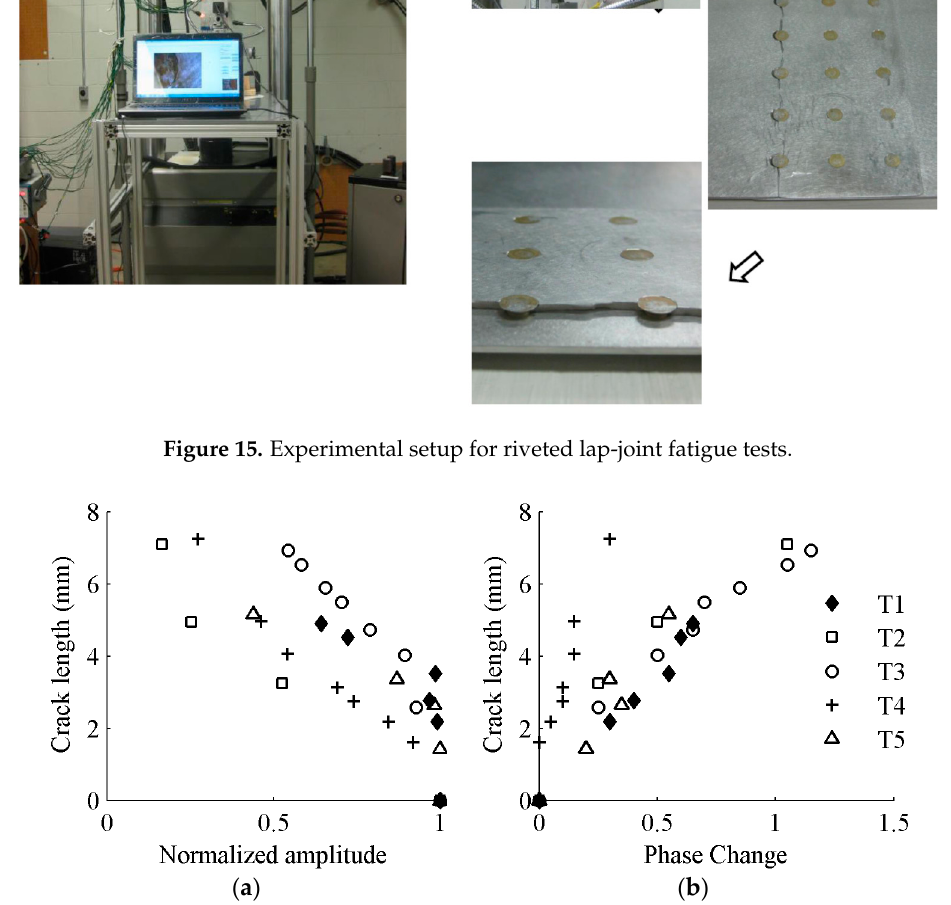
Figure 16. Crack length versus damage sensitive features obtained from in-situ testing of five lap-joint components named T1–T5: ( a ) normalized amplitude; and ( b ) phase change.